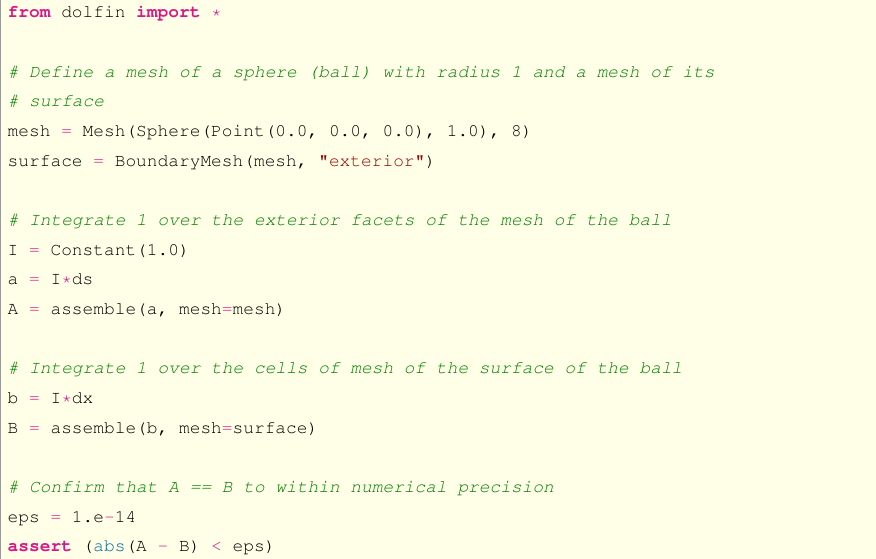
Fig. 5. DOLFIN Python code illustrating that an integral over the surface facets of a meshed ball is equivalent to the integral over the manifold mesh of the ball’s surface. This example is included in the Supplement as snippets/measures.py.